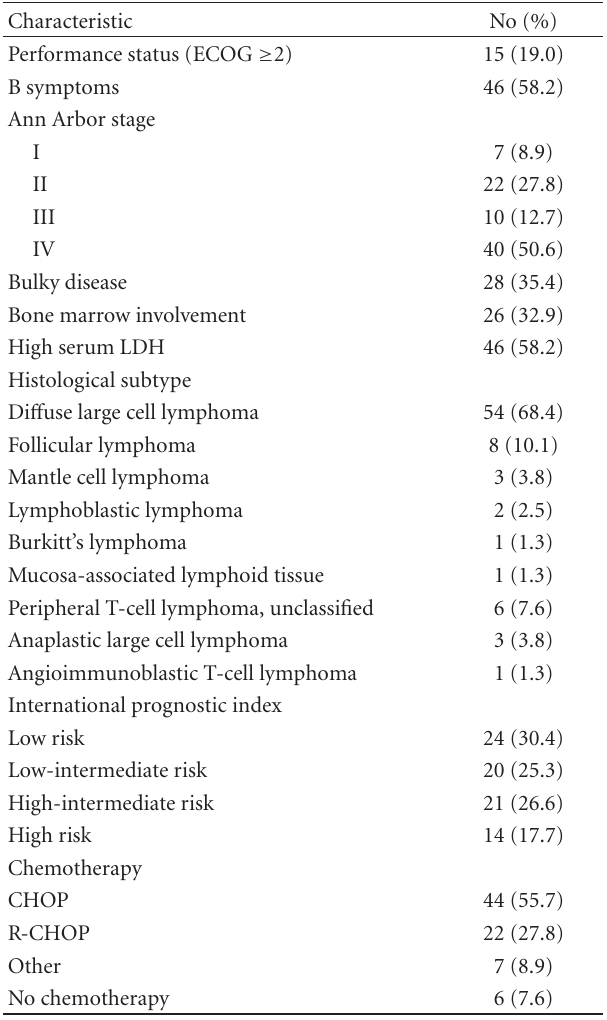
Table 1: Initial characteristics of 79 patients with de novo